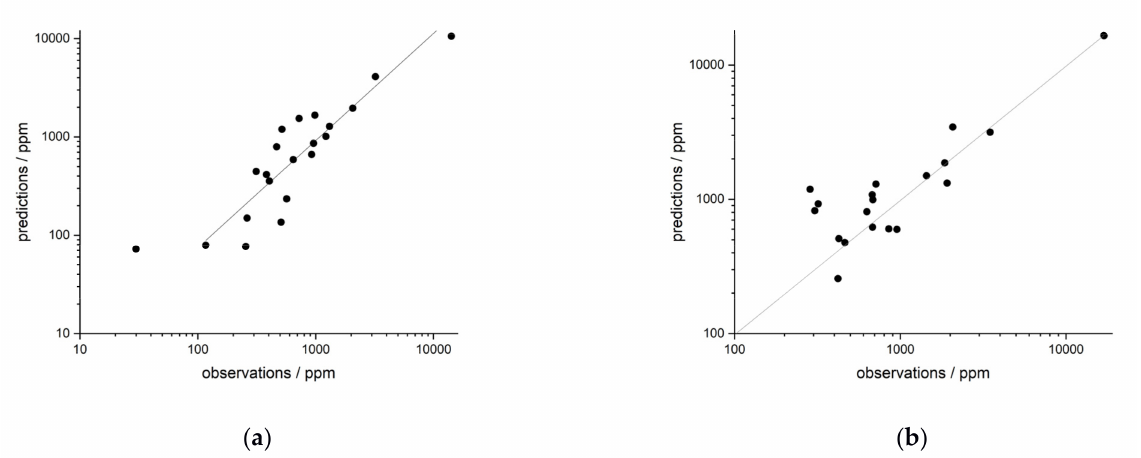
Figure 10. i PLS regression of field samples in rocks of ( a ) La and ( b ) Nd. The improvement of the regression is most obvious for the field samples in